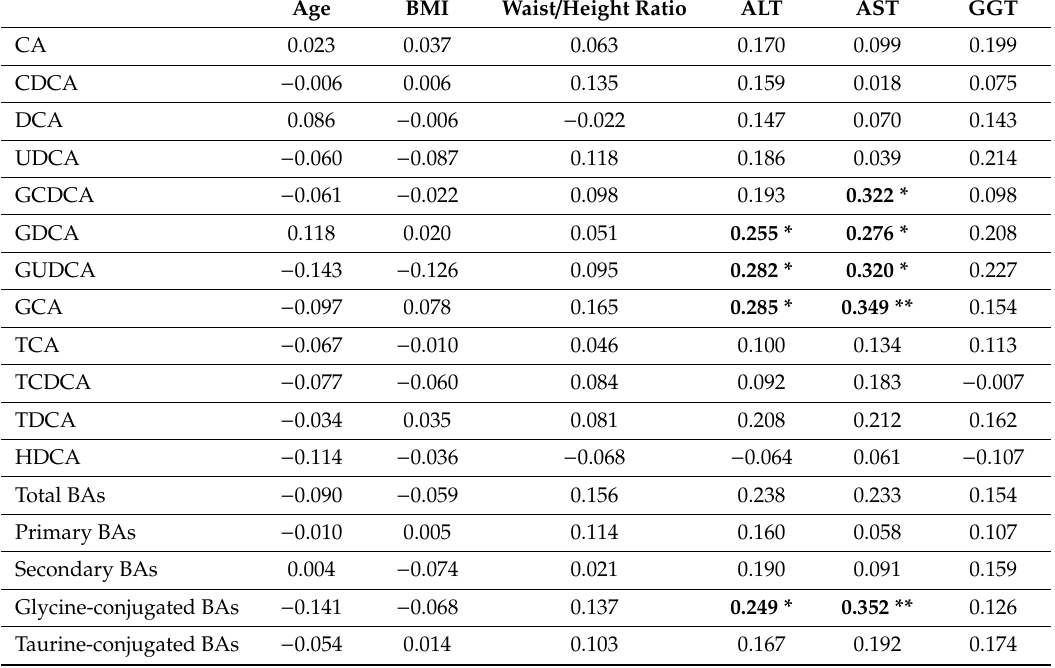
Table 4. Correlations between bile acids (Bas) and age, body mass index (BMI), waist / height ratio, and liver